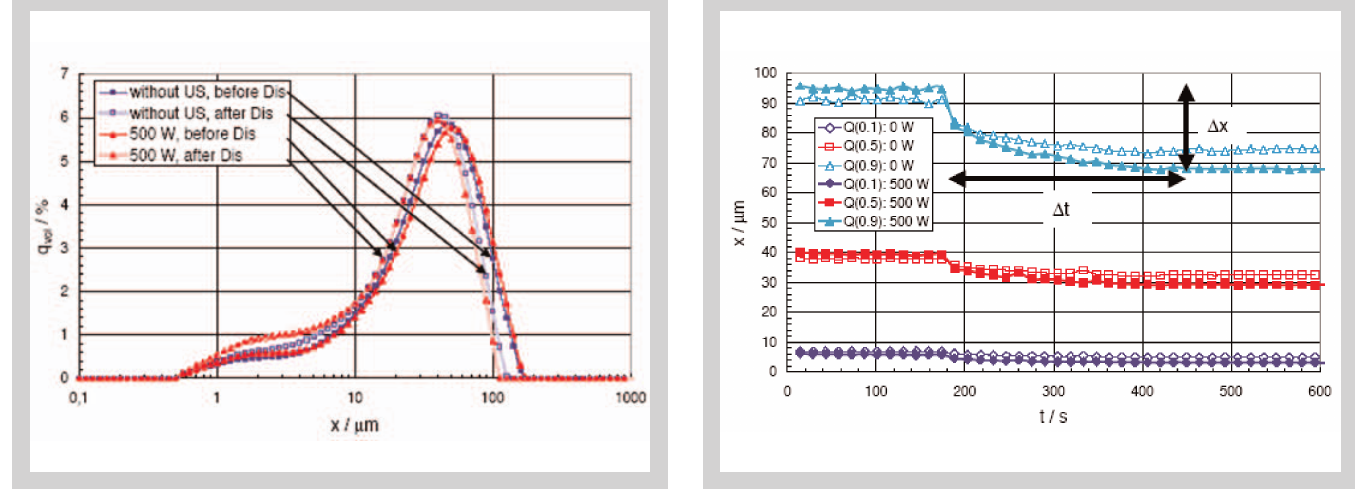
Figure 6: left: (a) Particle-size distrib- ution for (F = 56.5 %) for Pmax = 0 and 500 W, before and after the dispers- ing (50 W). (b) The values of Q(0.1), Q(0.5) and Q(0.9) for Pmax = 0 and 500 W during the dispersing (50